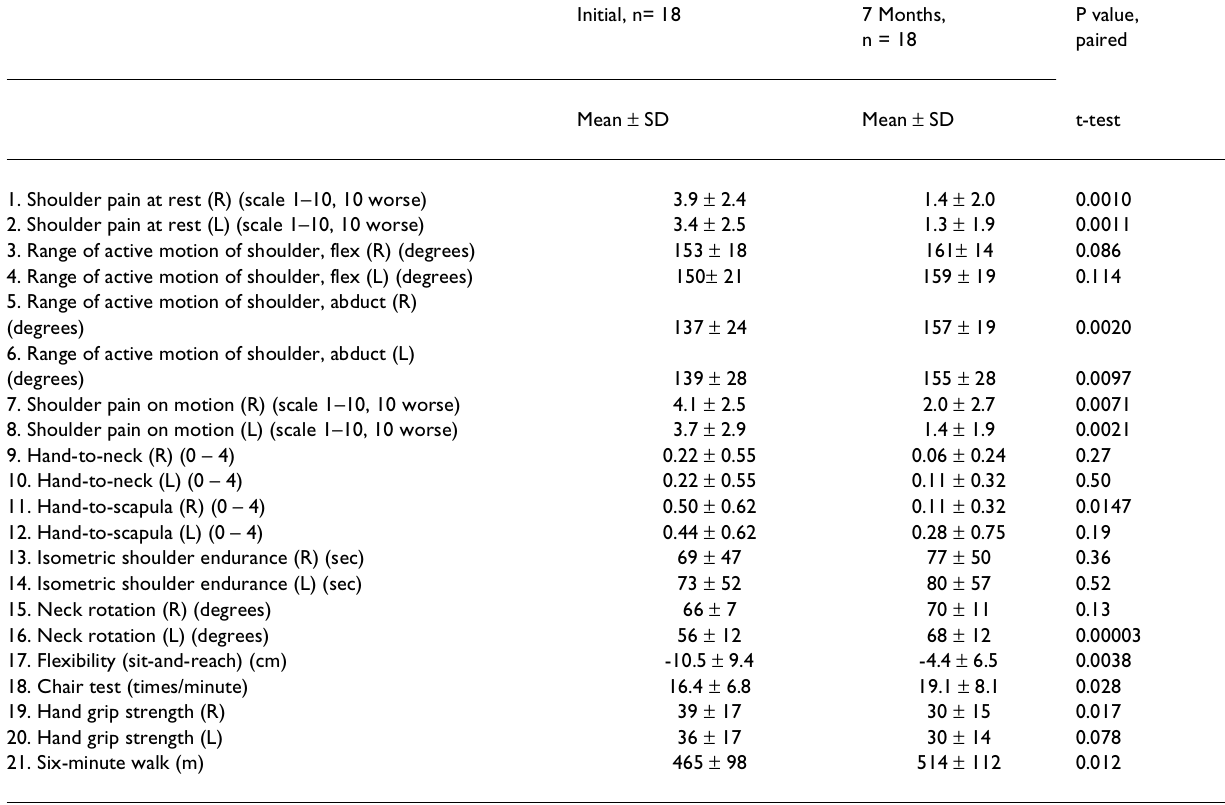
Table 2: Physical Evaluation of Subjects.